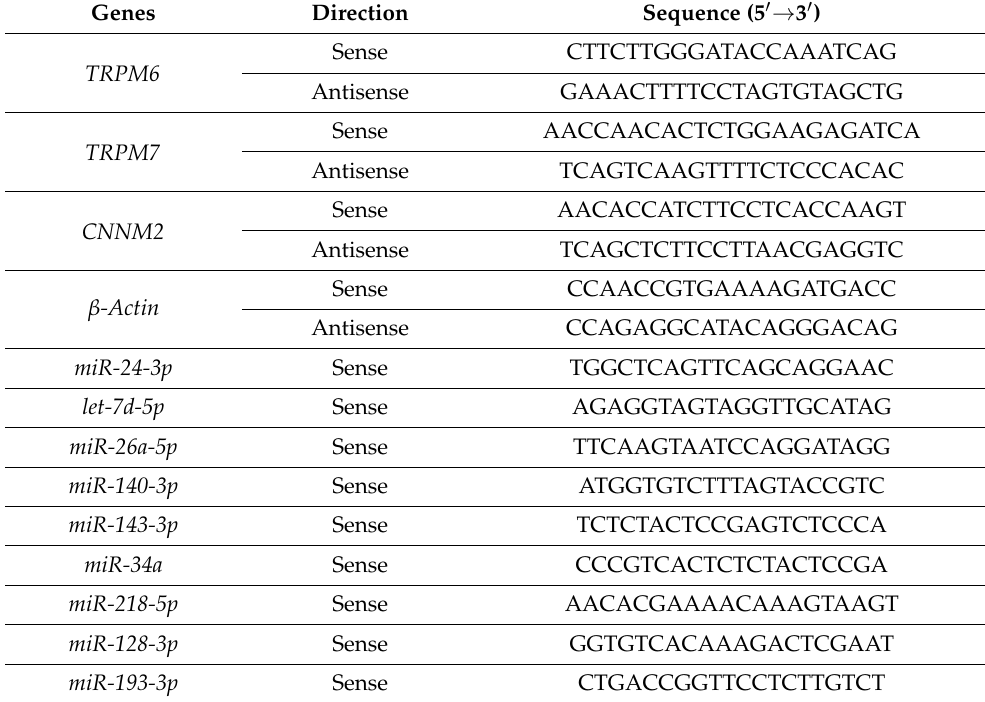
Table 1. Primer pairs for real-time